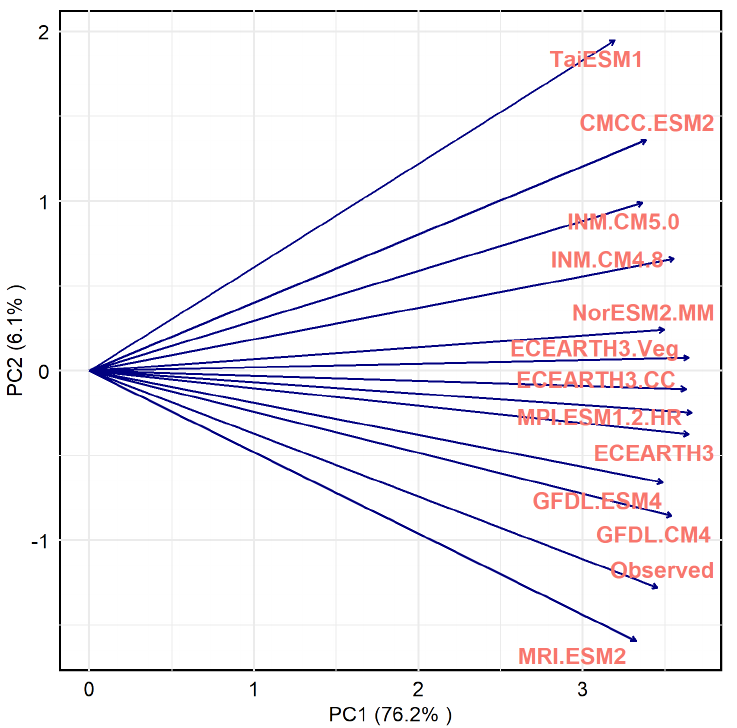
Figure 6. PCA biplot for the monthly precipitation series of the observed and climate model series.